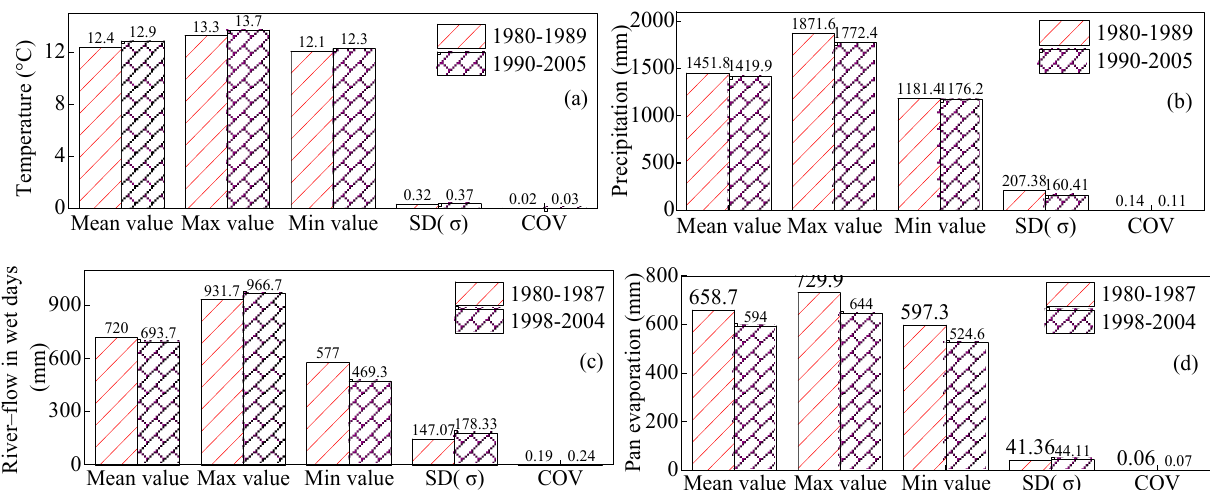
Figure 10. Statistics for ( a ) annual temperature (T), ( b ) precipitation (P), ( c ) and streamflow in wet season in the Qingyi river basin and ( d ) evaporation at Pengshan meteorological station for different scenarios (Data source; [130]).